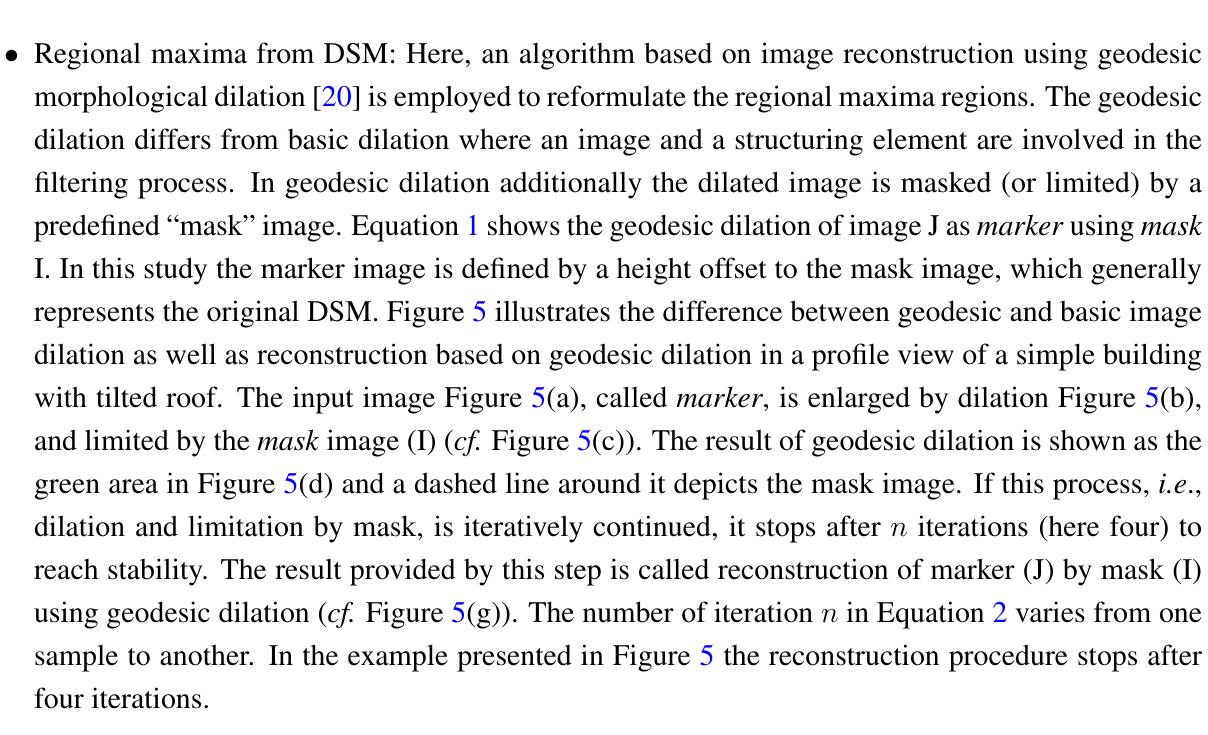
Figure 5. Applying geodesic reconstruction to extract the top pixels of a sample